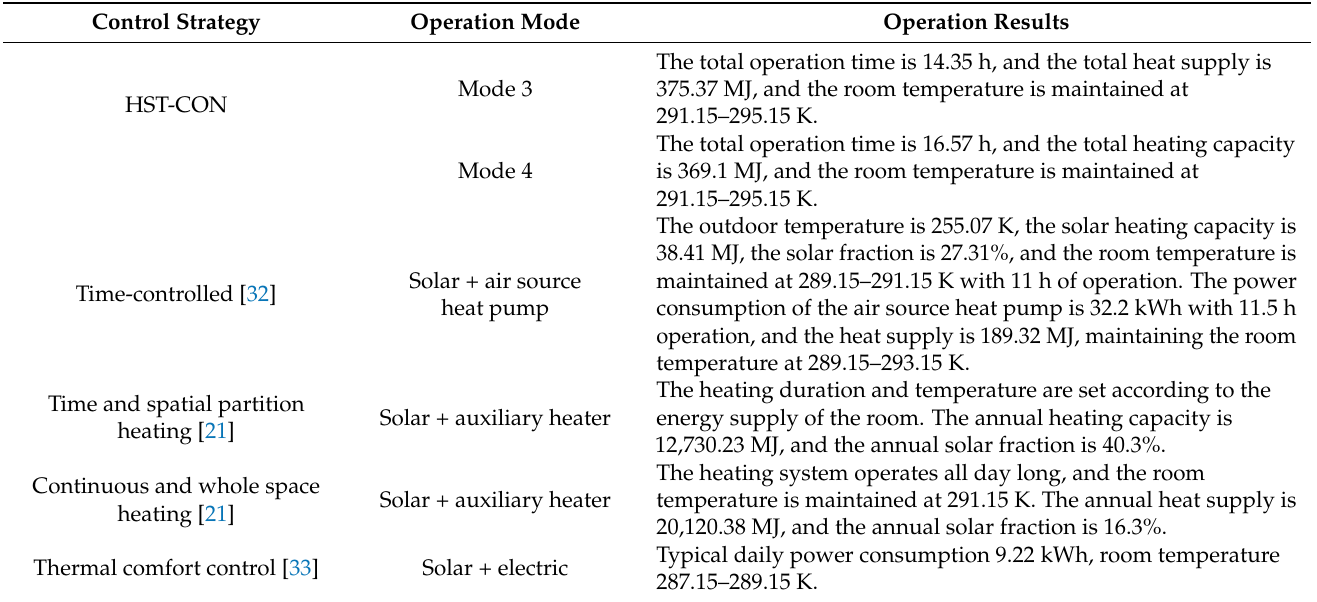
Table 2. Performance comparison of different heating control